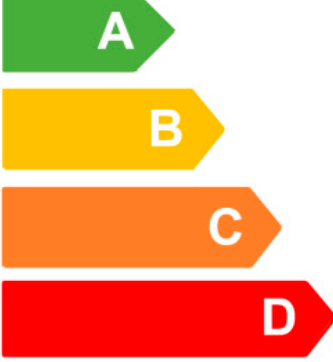
Figure 4. Label classes for the properties.